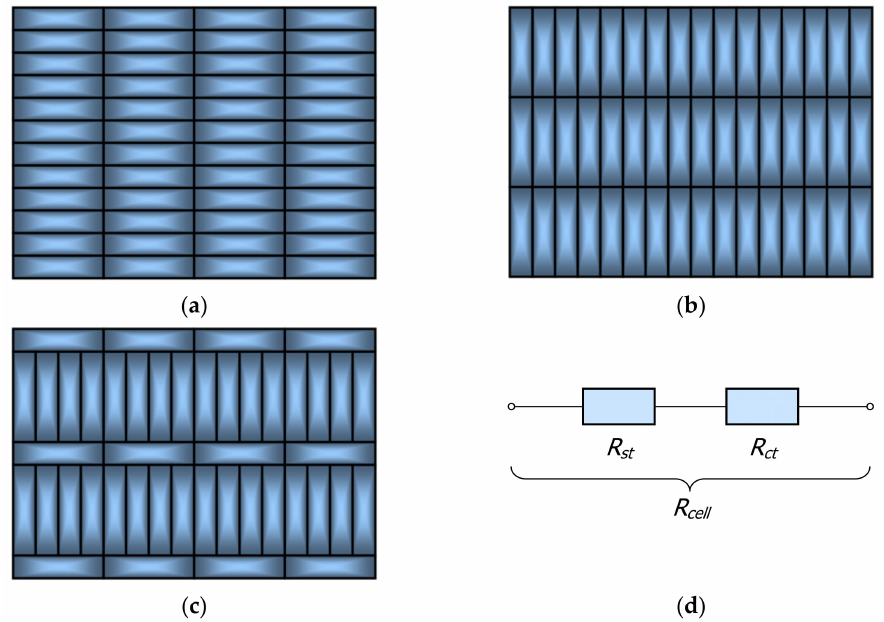
Figure 2. Samples of beds of rectangular bars with a horizontal ( a ), vertical ( b ) and mixed ( c ) arrange- ment, ( d ) the scheme of the resistances connection used to calculate total thermal resistance R cell